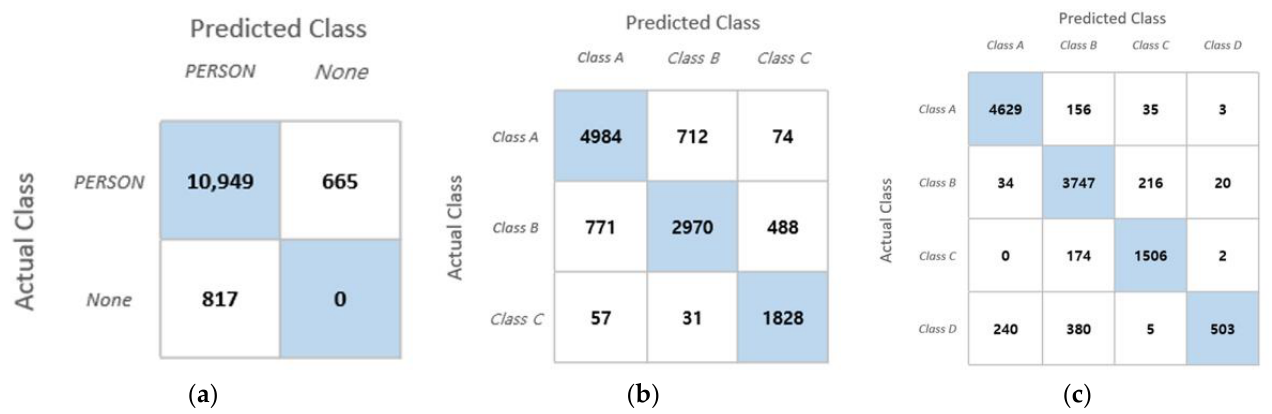
Figure 14. Object classification table of the three AI models (units: each): ( a ) Confusion matrix for the Yolov3-416 model; ( b ) Confusion matrix for the Yolov3-HSV model; ( c ) Confusion matrix for the Yolov3-Augment model.